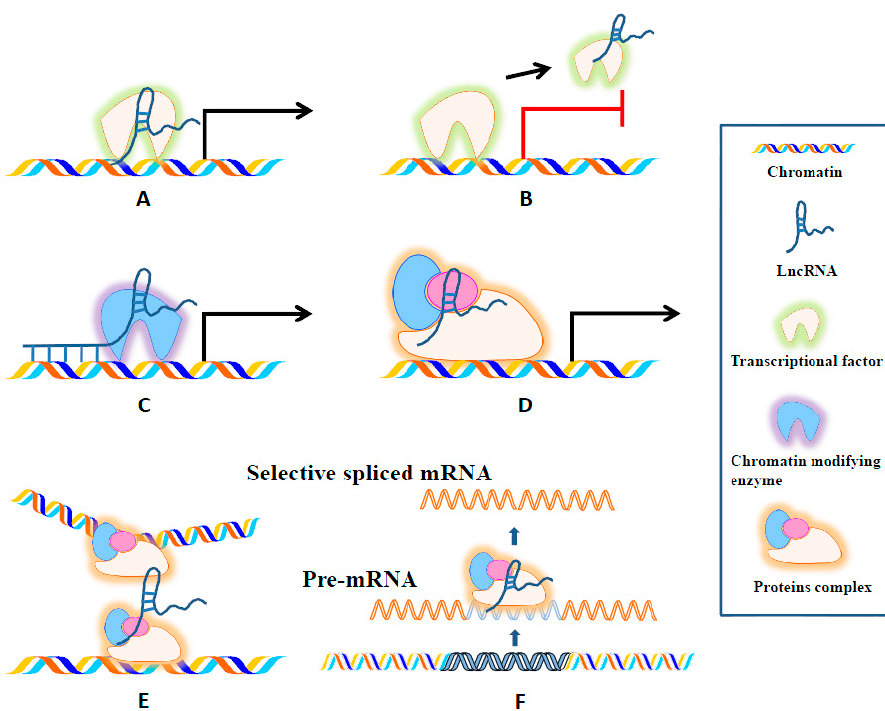
Figure 2. Schematic diagram of the six mechanisms of lncRNA functioning at transcriptional level. ( A ) LncRNAs can signal the activation of gene expression by integrating with one or more transcriptional factors; ( B ) LncRNAs can remove transcriptional factors from chromatin or they can compete for the miRNA target site, and, if successful, both mechanisms hault gene expression; ( C ) LncRNAs bind with chromatin, and this unit recruits chromatin modifying enzymes before guiding them to a target site for the initiation of gene expression; ( D ) LncRNAs can act as scaffolds to bring together multiple proteins and form ribonucleoprotein complexes, which subsequently induce gene expression; ( E ) LncRNAs regulate gene expression by acting on the spatial conformation of chromosomes; and ( F ) LncRNAs can hybridize to pre-mRNAs, block spliceosome recognition of splice sites, and regulate the alternative splicing of pre-mRNAs to produce different